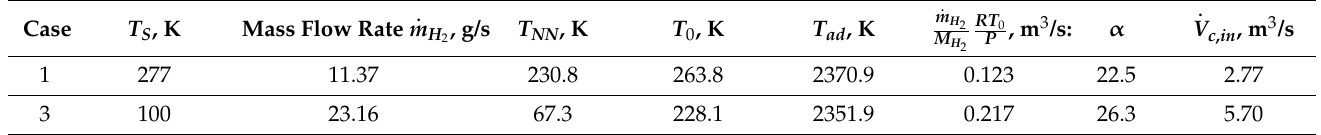
Table 5. Effect of storage temperature on combustion parameters and volumetric flow rate balance for limiting cases 1 and